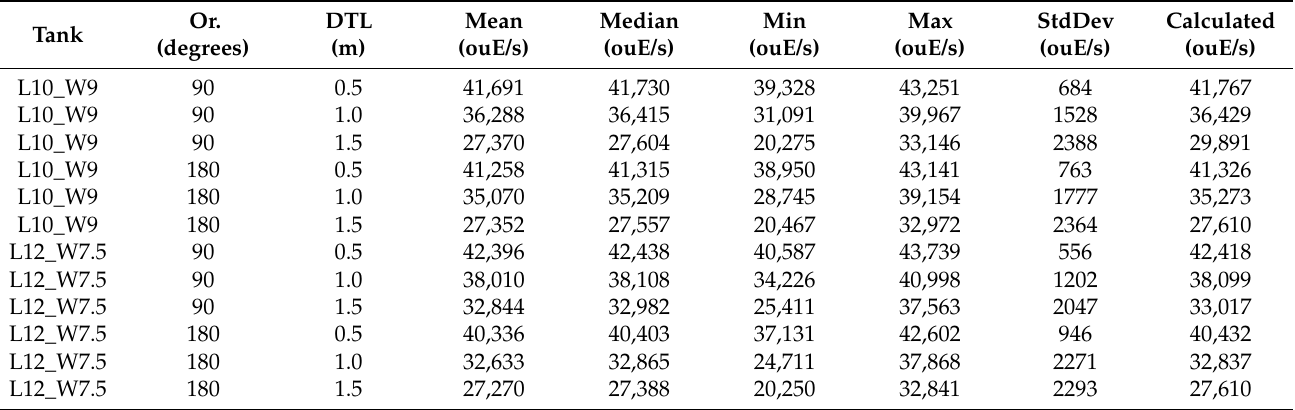
Table 9. The range of variation of odor emissions (ouE/s) with the bootstrap procedure and